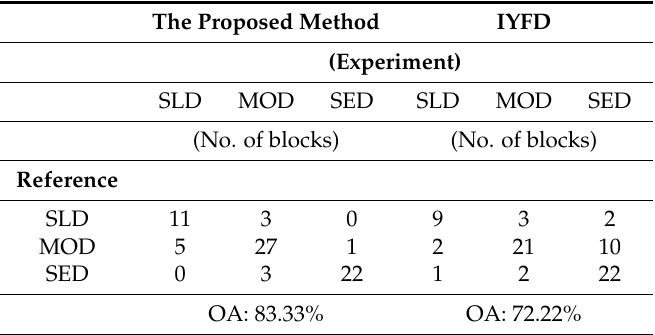
Table 2. Accuracy evaluation of the building earthquake damage assessment for the two methods